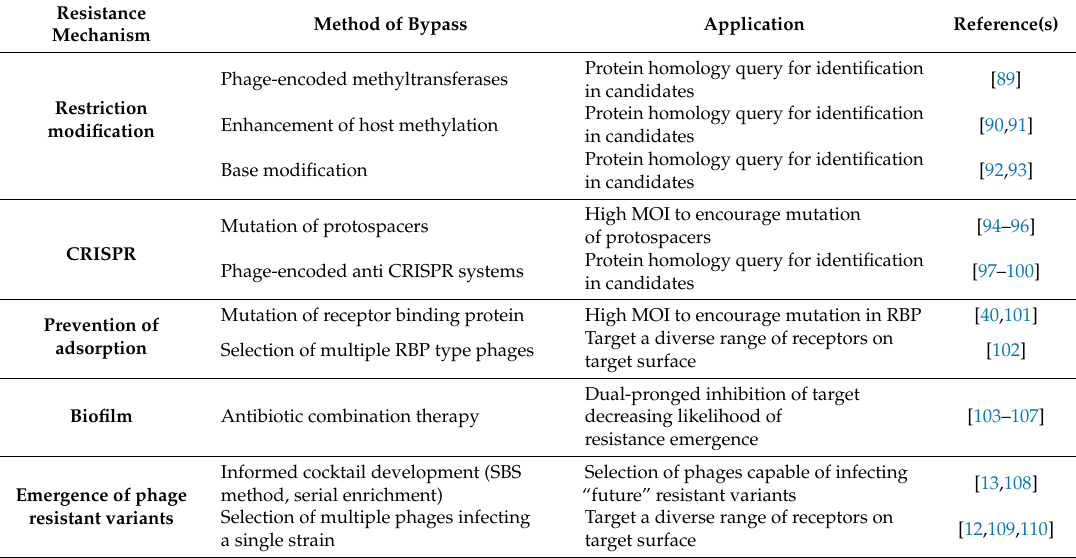
Table 1. Identification and application of methods to bypass phage resistance in target